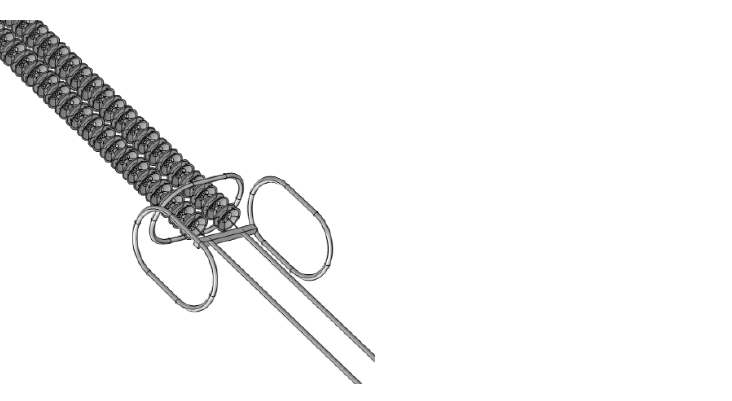
Figure 5. The coronal discharge condition of a tension insulator string grading ring and shielding ring at the outgoing side of phases A, B and C of the main transformer.